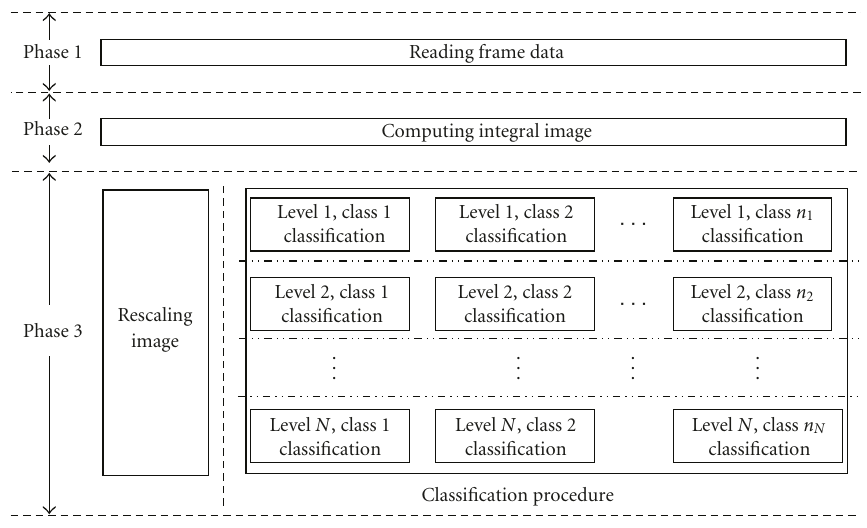
Figure 4: Skeleton of the system pipeline structure.